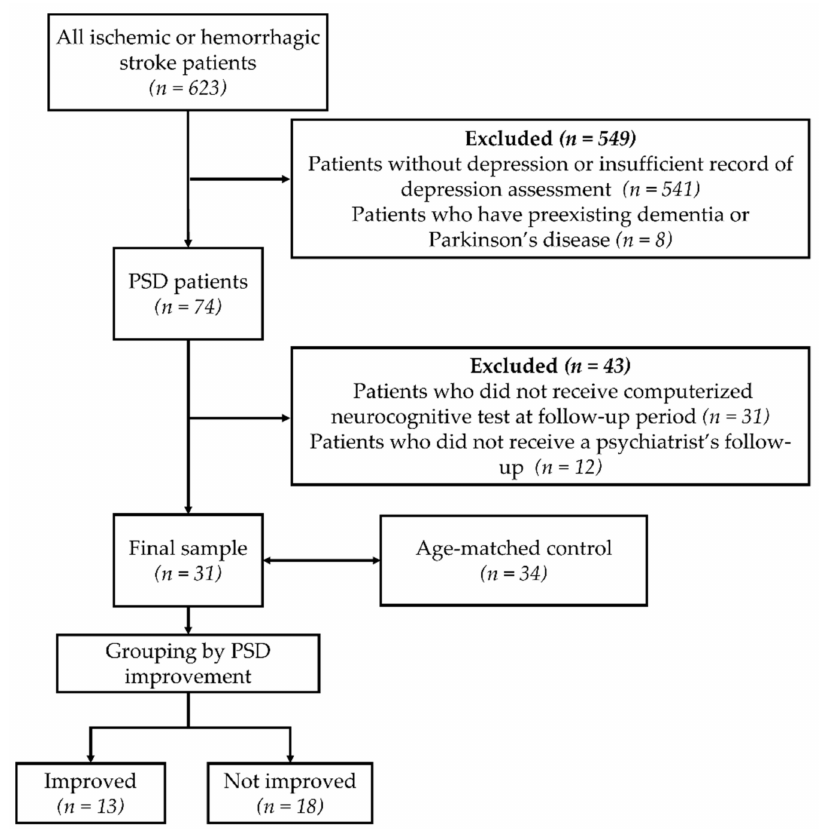
Figure 1. Flow and grouping of patients and controls. Abbreviation: PSD = poststroke